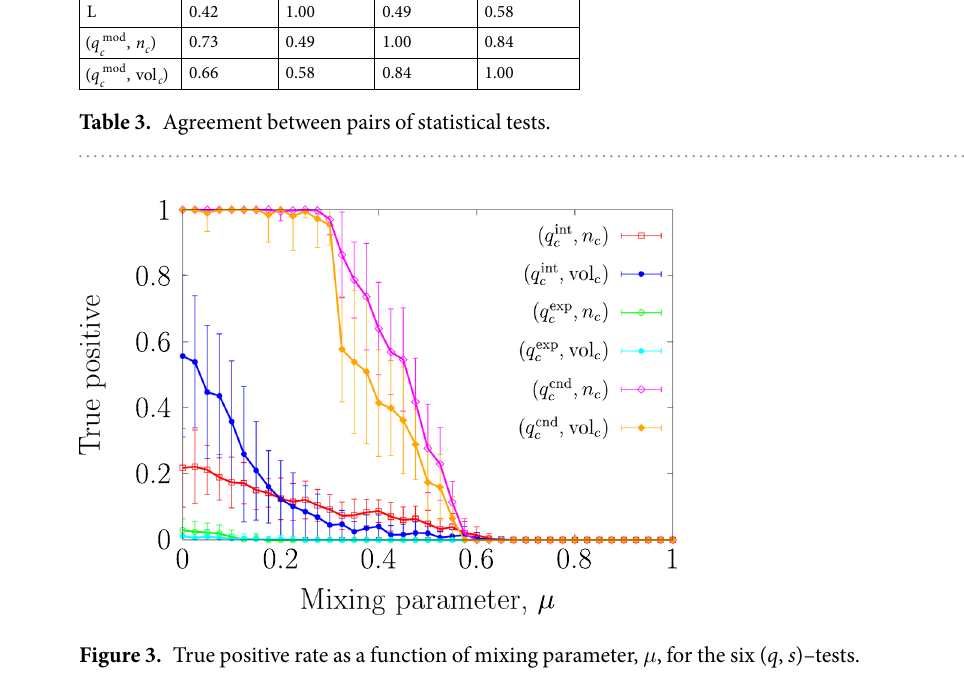
Figure 3. True positive rate as a function of mixing parameter, μ , for the six ( q , s